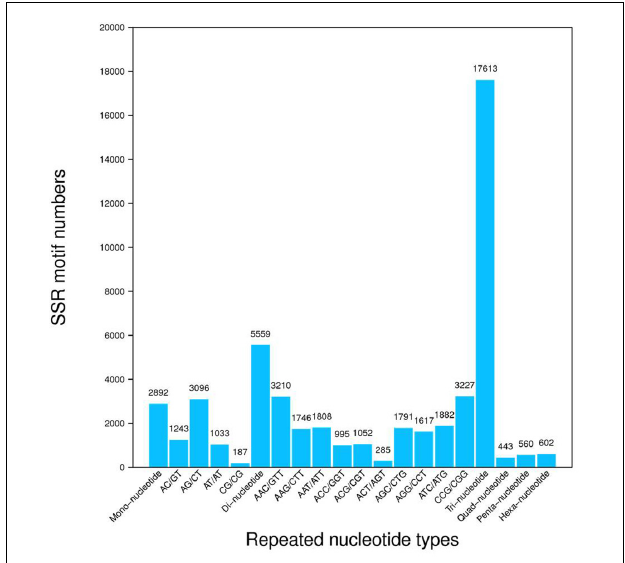
FIGURE 3 | Frequency distribution of simple sequence repeats (SSR). The x -axis indicates the type of SSR and the y -axis indicates the number of SSR.